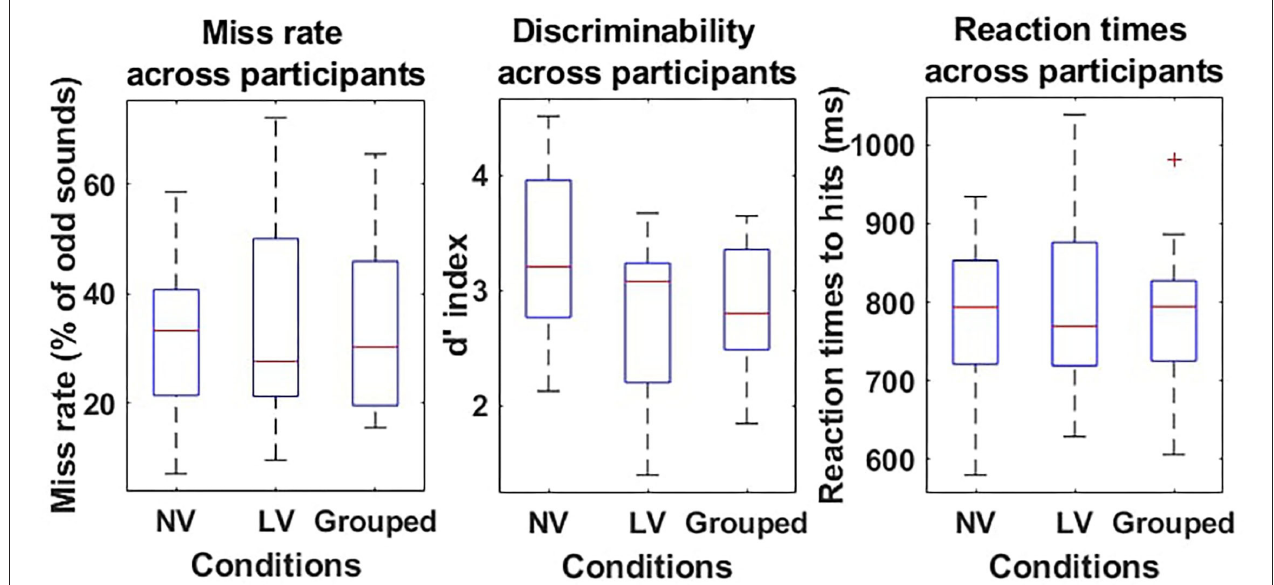
FIGURE 2 | Behavioral results of the oddball task during flight simulation. Miss rates ( % –left), discriminability d ′ (a.u.–middle), and reaction times (RT) ( ms–right) are presented as boxplots for the Normal visibility condition (NV–left-hand side boxplot), the low visibility condition (LV–middle boxplot), and the two conditions grouped (Grouped–right-hand side boxplot) for each measure. For each boxplot, the red line shows the median and the bottom and top of each box show the 25 and 75th percentile, respectively. revealed a tendency for an effect of the type of stimulus (hit vs.